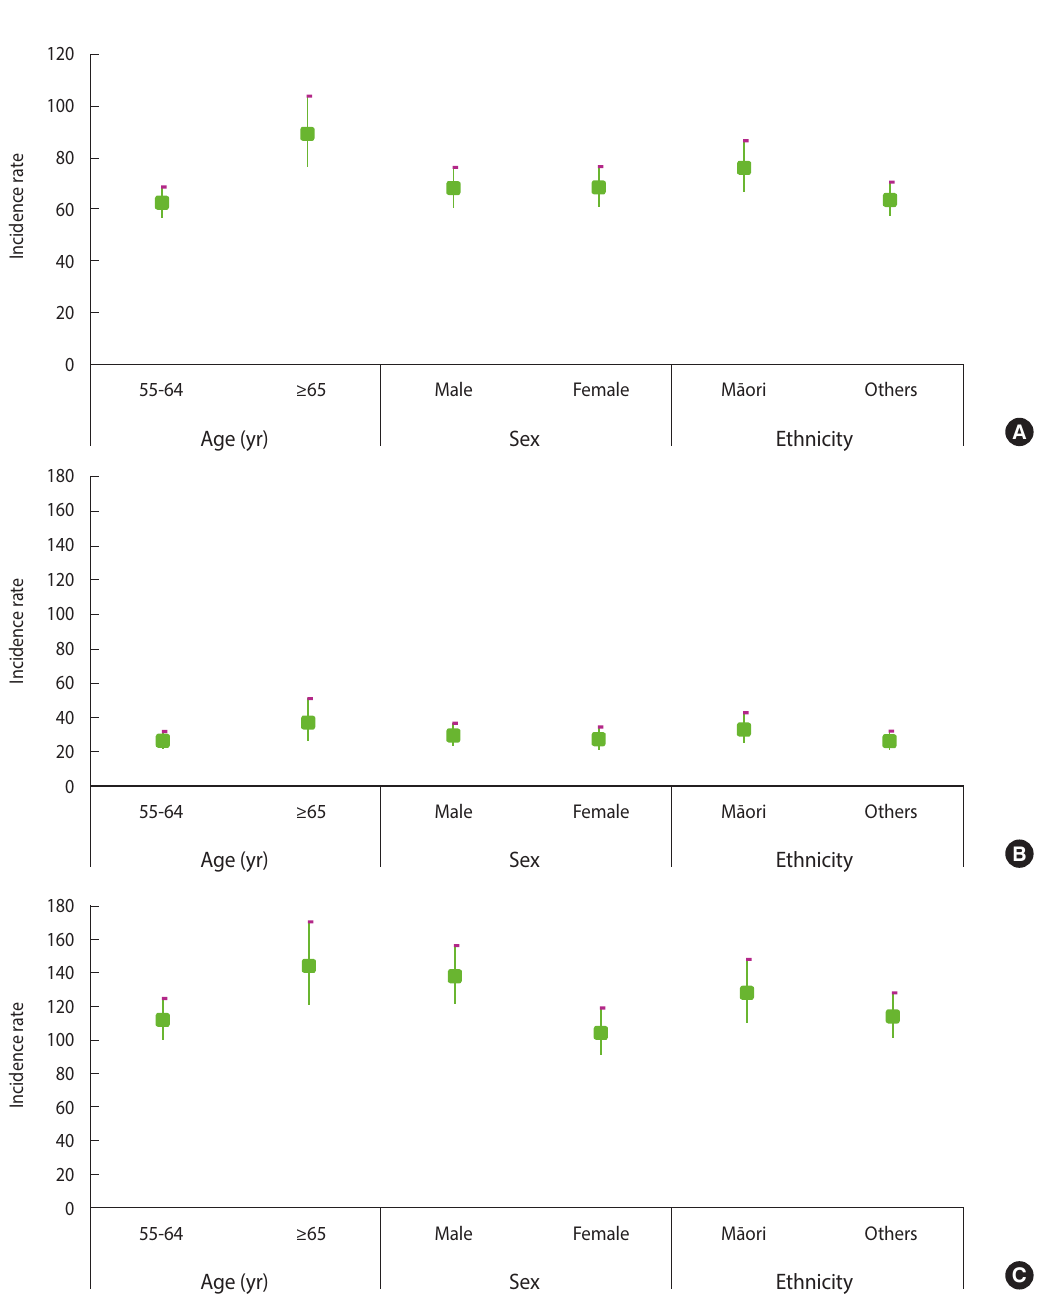
Figure 1. Incidence rates of multimorbidity by age, sex, and ethnicity strata among adults (A) aged 55 and over, 2006-2016, (B) without a chronic condition at the baseline, 2006-2016, and (C) with 1 chronic condition at the baseline, 2006-2016, in New